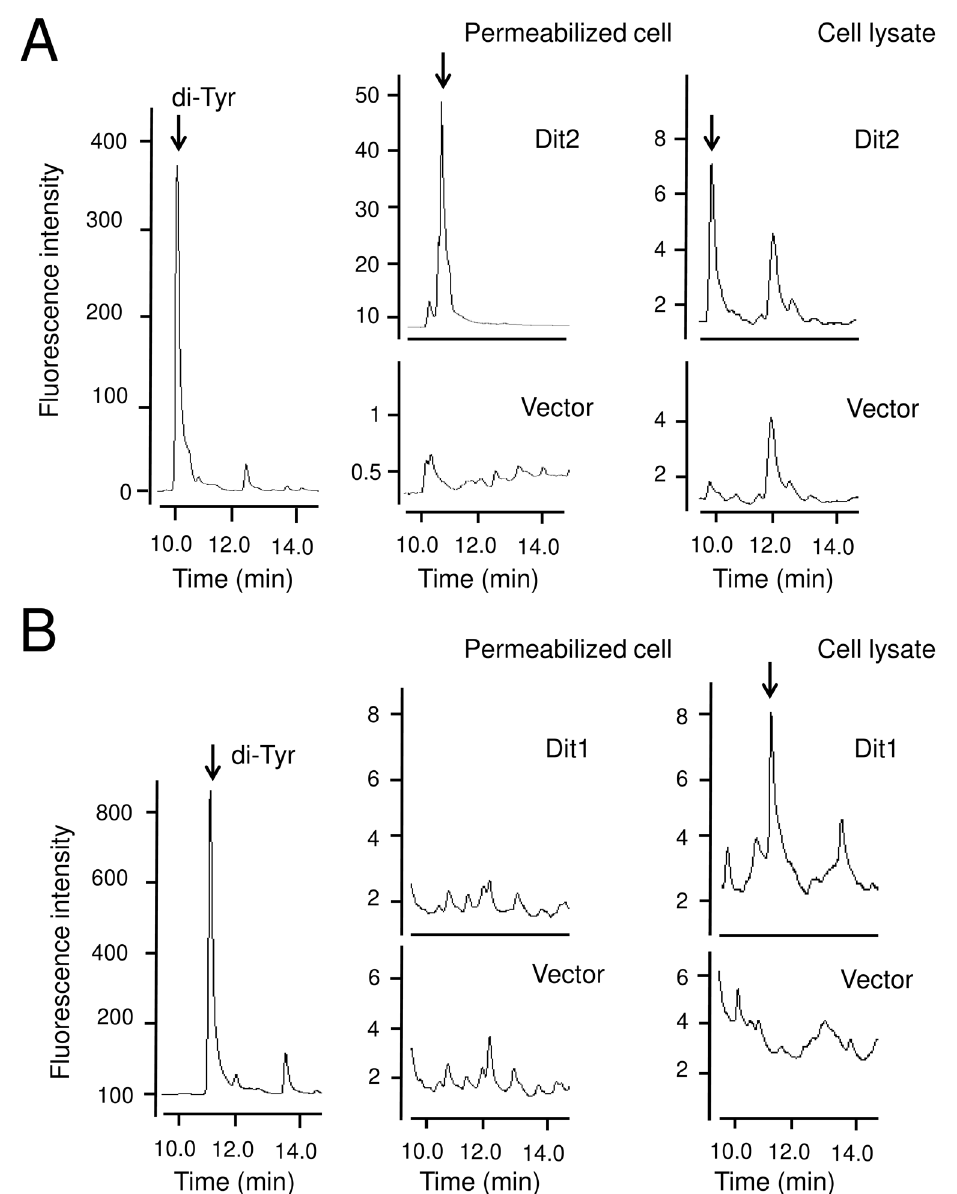
Figure 5. In vitro Dit2 assay to assess the presence of formyl tyrosine in Dit1-expressing cells. ( A ) Vegetative cells harboring pRS426GAL1-DIT2-FlAG (Dit2) or pRS426GAL1 (Vector) were permeabilized or lysed and incubated with formyl tyrosine (f-Tyr). The reaction mixtures were hydrolyzed with 6 N HCl and analyzed by HPLC. Di-tyrosine (di-Tyr) is shown as a control. Arrows indicate dityrosine peaks. ( B ) Lysates of vegetative cells harboring pRS424GAL1-DIT1-GFP (Dit1) were permeabilized or lysed and mixed with lysates of vegetative cells harboring pRS426GAL1-DIT2-FlAG (Dit2). The mixtures were incubated with tyrosine. The reaction mixtures were hydrolyzed with 6 N HCl and analyzed by HPLC. Dityrosine (di-Tyr) is shown as a control. Arrows indicate dityrosine